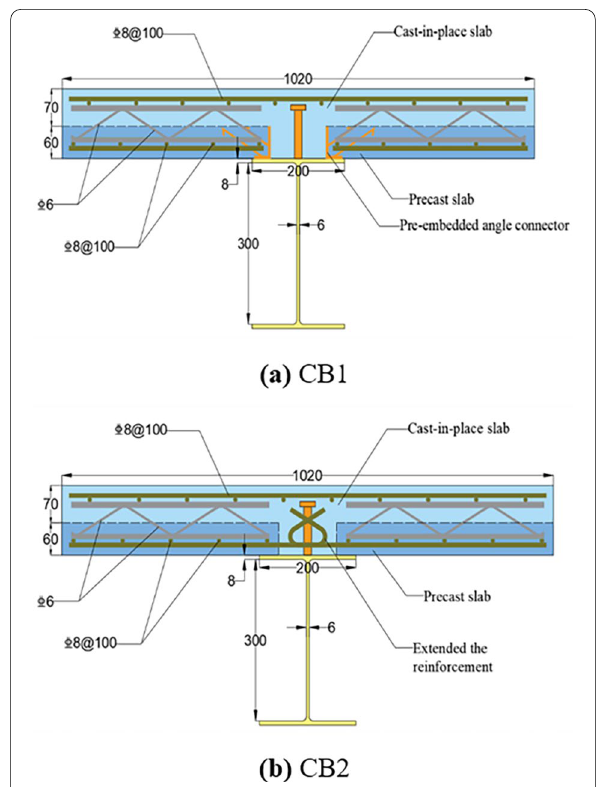
Fig. 2 Composite beam section: a CB1, b CB2.